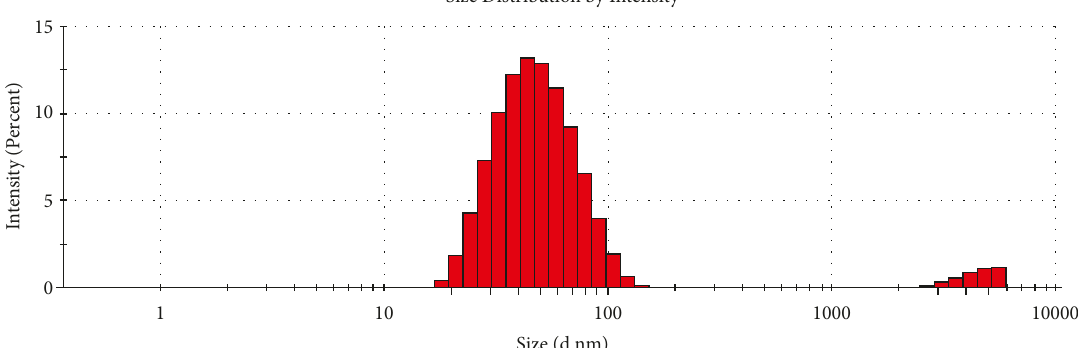
Figure 3: Size distribution against intensity histogram from zeta potential for room temperature synthesized Au NPs using Physalis peruviana .